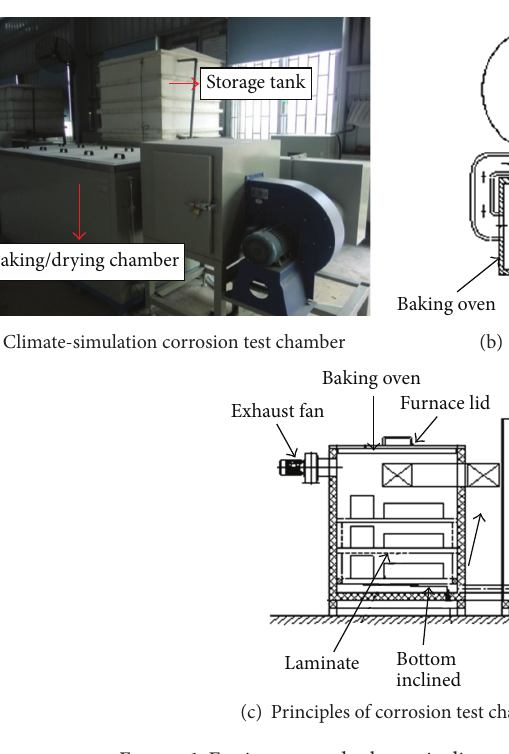
Figure 1: Equipment and schematic diagram of dry-wet cycling experiment.